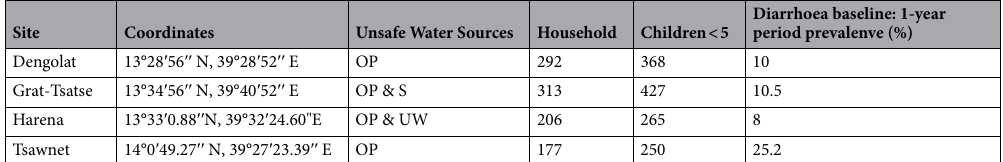
Table 2. Characteristics of the case study sites. OP, open pond; S, stream; UW, unprotected well.